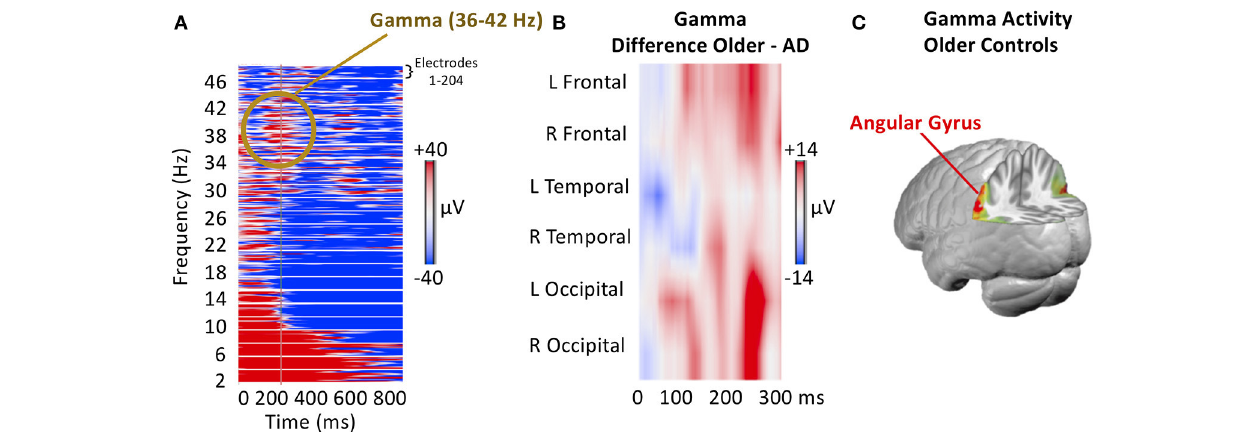
FIGURE 3 | EEG Frequency modulation induced by the presentation of autobiographical photographs. (A) Example of induced power changes from 2 to 44Hz after subjects responded, indicating having recognized a picture as self-related. Each line represents the 257 electrodes in the given frequency. Note the power increase in theta and gamma and the decrease in alpha. (B) The induced gamma power difference between participants with ADRD and age-matched cognitively-unimpaired controls. Electrodes are averaged for regions of interest, as indicated. Note the more considerable gamma power increase for recognized pictures in controls as compared to ADRD participants. (C) Source localization of task-related gamma activity increase averaged across the period of 100–300ms after stimulus onset. Note the left inferior parietal activity in the region of the angular gyrus.